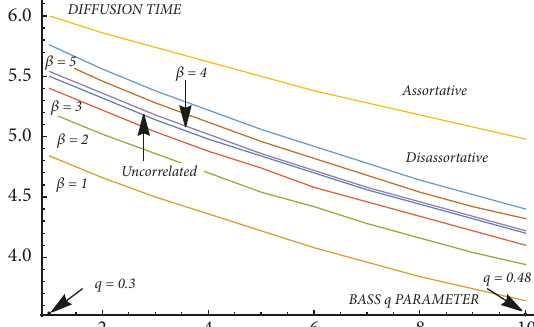
Figure 2: Time of the diffusion peak (in years) for the Bass model on different kinds of scale-free networks with exponent 𝛾 = 3 , as a function of the imitation coefficient 𝑞 . All networks have maximum degree 𝑛 = 100 ( 𝑁 ≃ 10 4 ). The 𝑞 coefficient varies in the range 0.3−0.48 , corresponding to a typical set of realistic values in innovation diffusion theory [20]. The publicity coefficient is set to the value 𝑝 = 0.03 (see Figure 9 for results with an inhomogeneous 𝑝 𝑘 depending on the link class 𝑘 = 1,...,𝑛 ). The lines with 𝛽 = 1,2,3, 4, 5 correspond to BA networks with those values of 𝛽 . Their assortativity coefficients are, respectively, 𝑟 = −0.104, −0.089,−0.078,−0.071, −0.065 . The disassortative network is built with the Newman recipe (Section 3.4) with 𝑑 = 4 and has 𝑟 = −0.084 . The assortative network is built with our recipe (Section 3.3), with 𝛼 = 1/2 , and has 𝑟 = 0.863 .